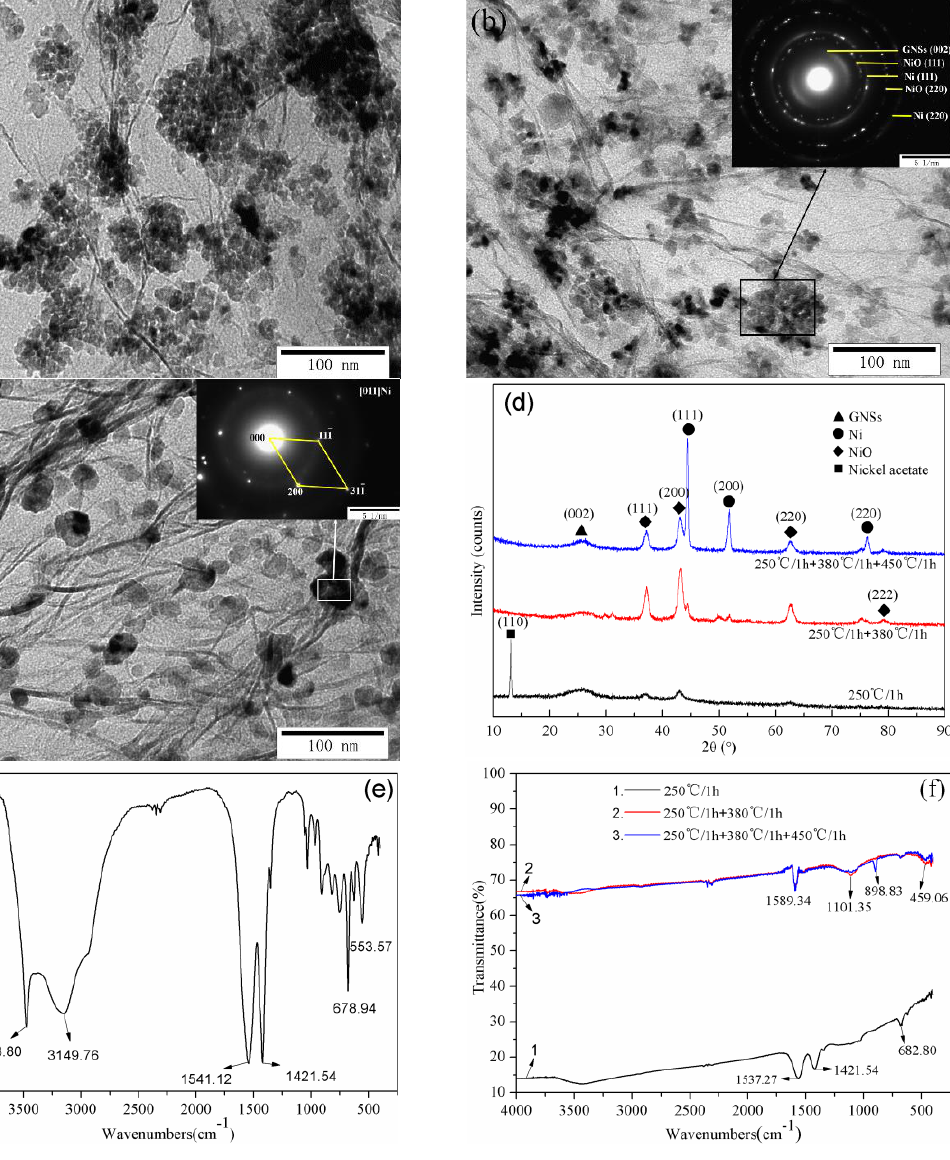
Figure 4. TEM images of the mixture of GNSs and nickel acetate tetrahydrate at ( a ) 250 °C/1 h, ( b ) 250 °C/1 h + 380 °C/1 h, and ( c ) 250 °C/1 h + 380 °C/1 h + 450 °C/1 h; ( d ) XRD patterns; and ( e , f ) FTIR spectra of nickel acetate tetrahydrate and the mixture during the segmented pyrolysis processes.